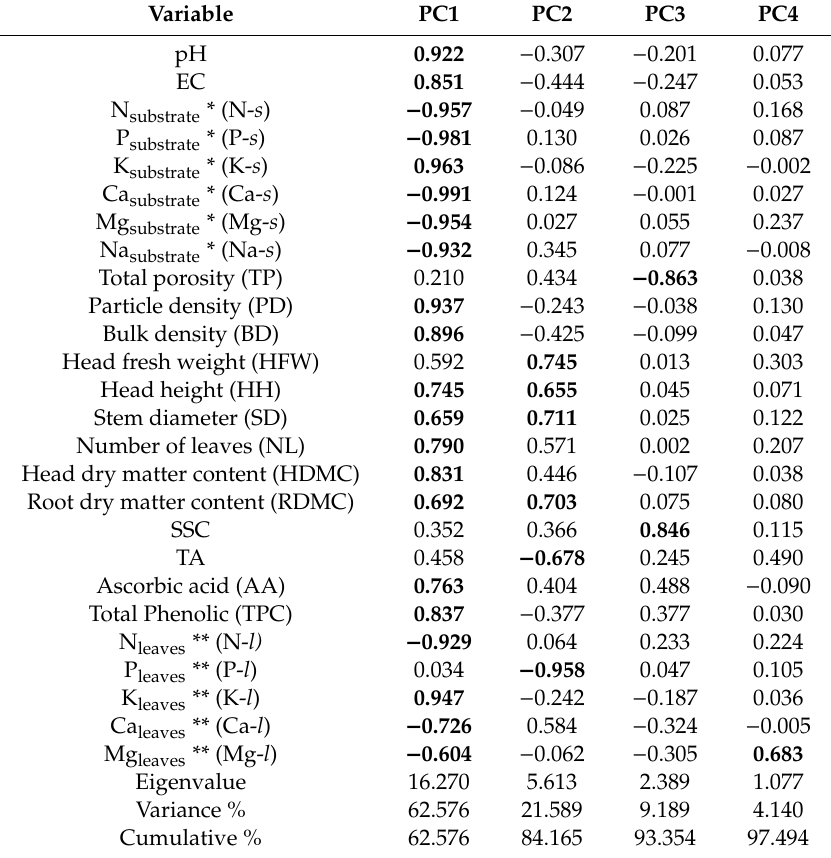
Table 6. Loadings scores for principal components PC1, PC2, PC3 and